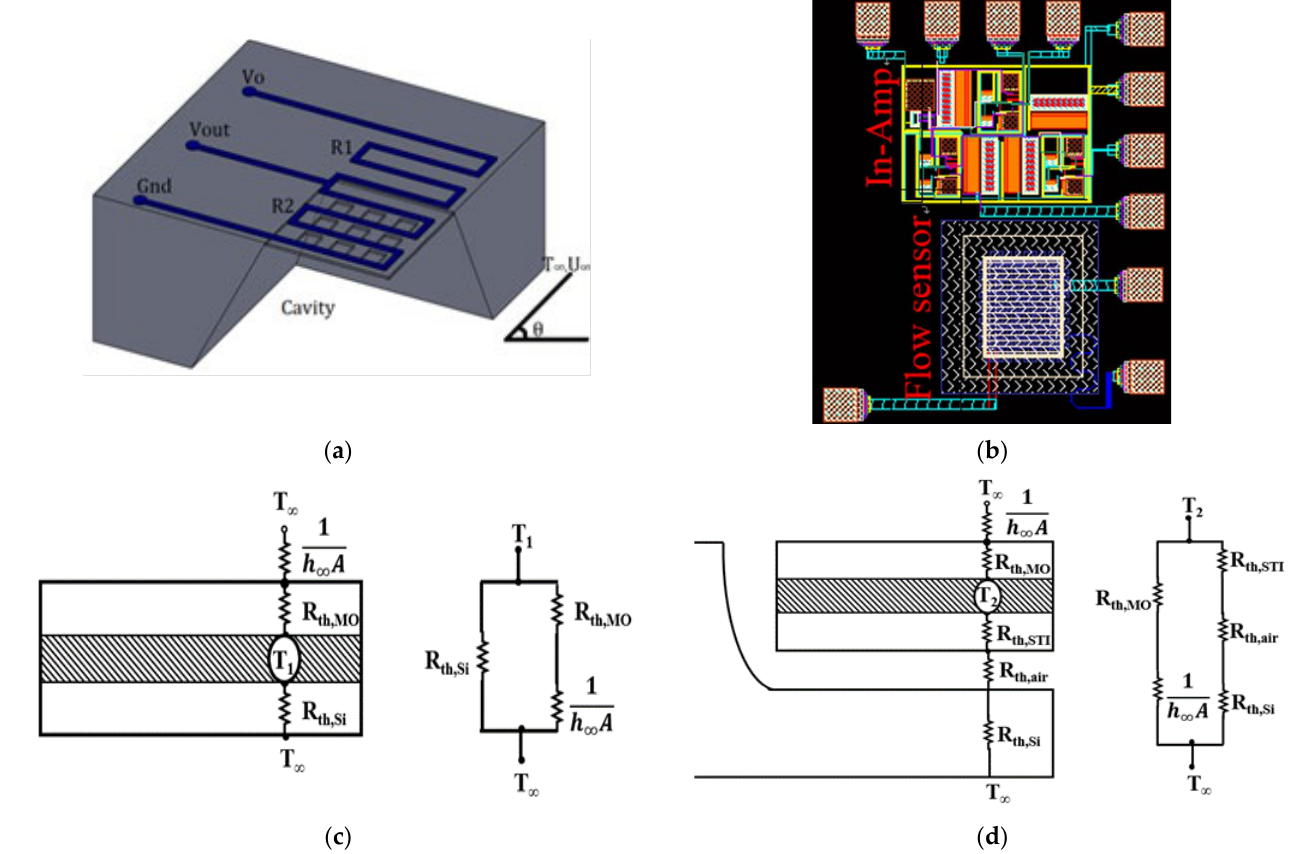
Figure 7. Flow sensor design: ( a ) the self-heating half-bridge RTDs R 1 and R 2 ; ( b ) layout diagram of flow sensor and amplifier; ( c ) 1D thermal resistance (R th ) model of the RTD R 1 with T 1 on Si substrate; and ( d ) 1D thermal resistance model of the RTD R 2 with T 2 on the floating MEMS area with air gap. Based on the UMC 0.18 µm standard 1P6M CMOS foundry with the MEMS post-